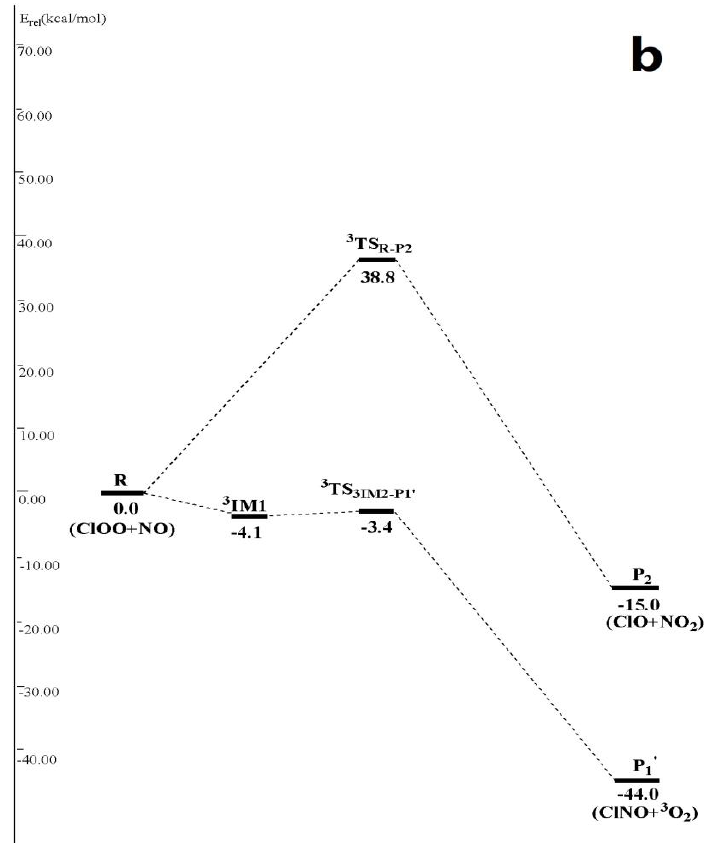
Figure 2. ( a ) Schematic singlet potential energy surfaces of each product channels for ClOO + NO reaction at the CCSD(T)/6-311 + G(2df)//MP2/6-311 + G(2df) + ZPE level. TS IM1-P3 is obtained at the CCSD (T)/6-311 + G(2df)//MP2/6-311G(d) + ZPE level, and TS IM2-P3 is obtained at the CCSD (T)/6-311 + G(2df)//B3LYP/6-311 + G(2df) + ZPE level; ( b ) Schematic triplet potential energy surfaces of each product channels for ClOO + NO reaction at the CCSD(T)/6-311 + G(2df)//MP2/6-311 + G(2df) + ZPE level.